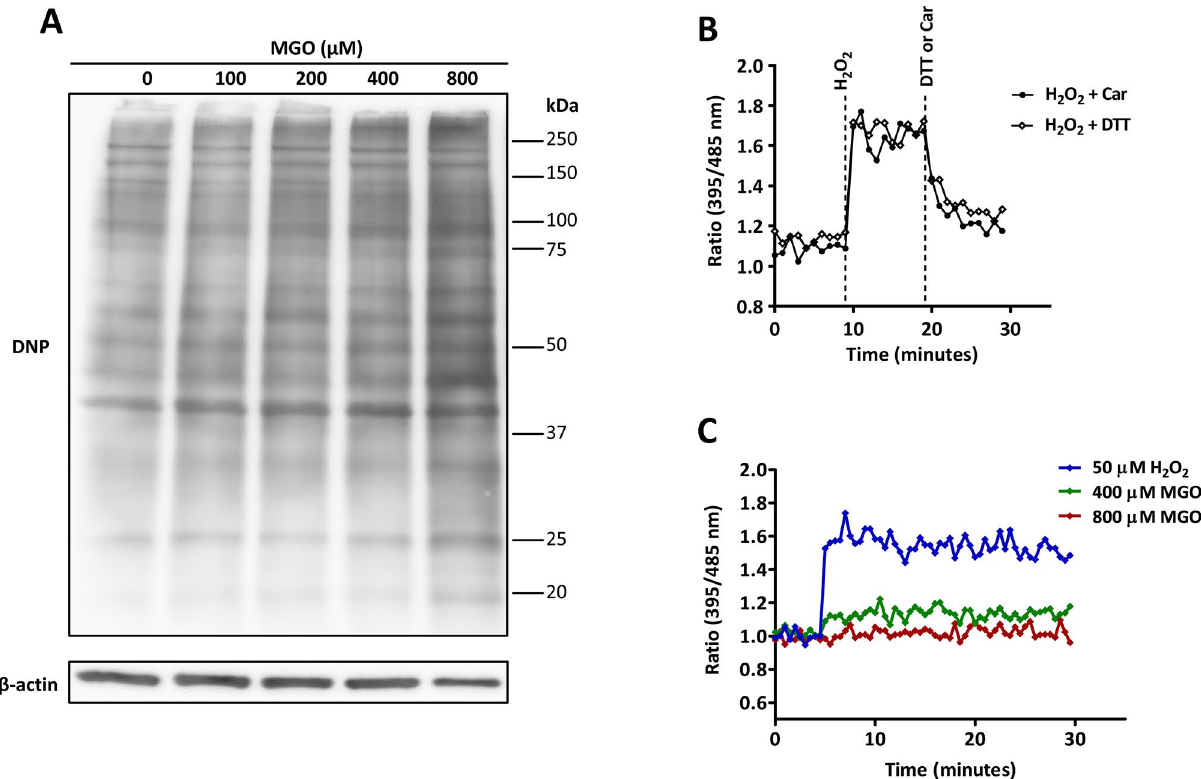
Figure 7. MGO causes protein glycation but not oxidative stress in HUVECs. ( A ) HUVECs were treated with varying concentrations of MGO for 5 h. Hereafter, DNP-derivatized cell lysates were subjected to immunoblotting to assess protein carbonylation. β-actin as loading control was made using the same amount of samples processed by SDS–polyacrylamide gel-electrophoresis. Displayed are the cropped blots and full-length blots are provided in Supplementary Fig. S6. (B) HUVECs expressing roGFP3 were excited at 395 nm and at 485 nm, and the ratio of emission at 520 nm was calculated. After 10 min, cells were challenged with 50